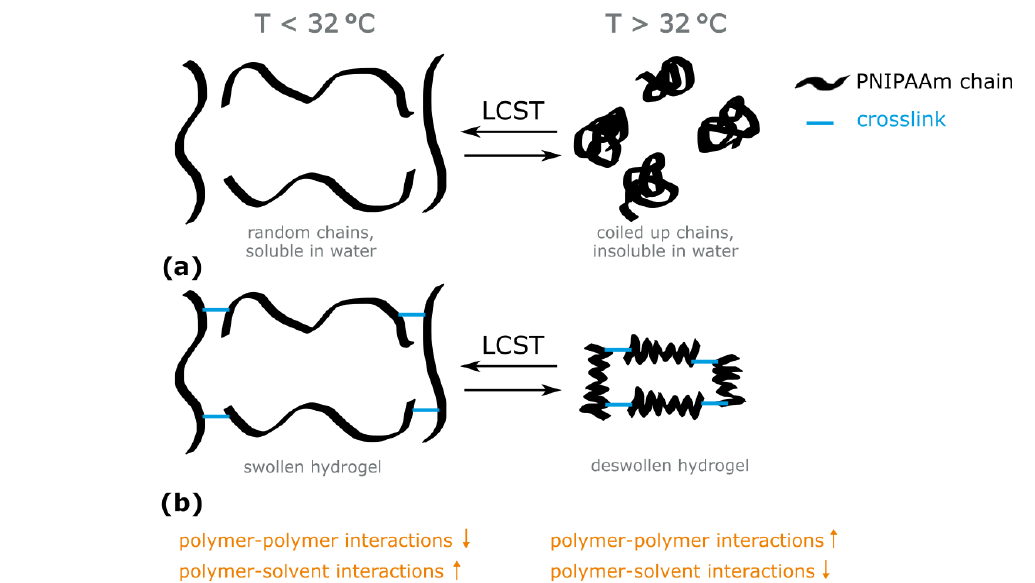
Scheme 1. Schematic representation of the behavior of (a) PNIPAAm chains and (b) PNIPAAm hydrogels in water below and above the lower critical solution temperature (LCST, 32 ◦